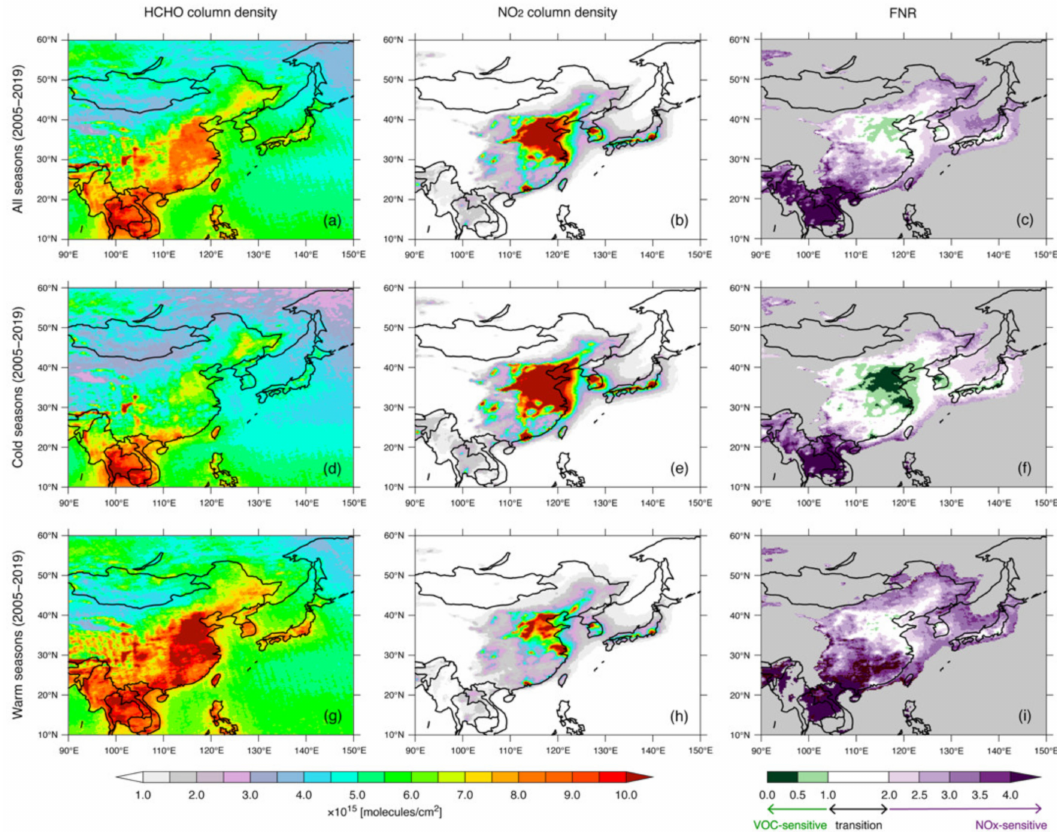
Figure 1. Spatial distribution of ( a , d , g ) HCHO column density, ( b , e , h ) NO 2 column density, and ( c , f , i ) FNR over East Asia averaged over 15 years (2005–2019) during ( a – c ) all seasons, ( d – f ) cold seasons (October to March), and ( g – i ) warm seasons (April to September). FNR is analyzed at grid points where NO 2 column density is greater than 1.0 × 10 15 molecules cm − 2 (white in ( b , e , h